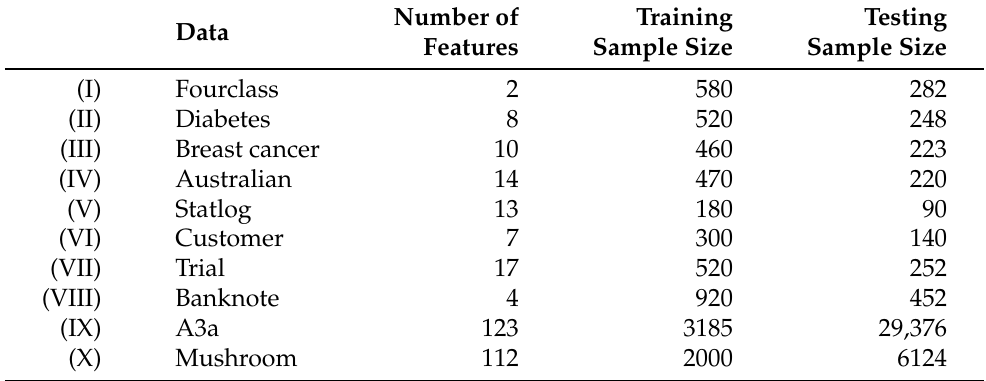
Table 4. Summaries of UCI